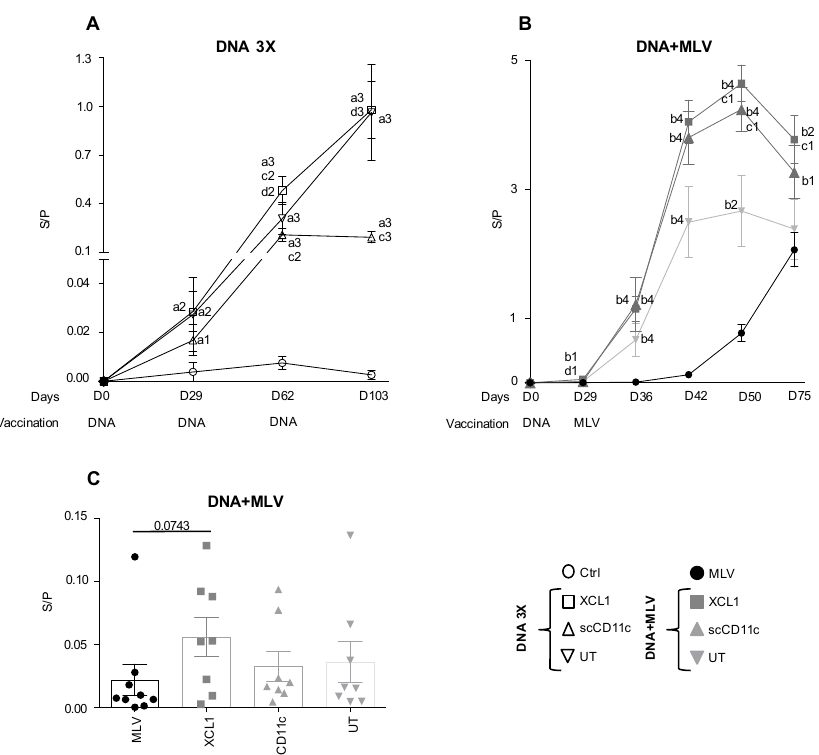
Figure 6. Anti-N IgG responses in serum and nasal secretions induced by DNA 3X and DNA + MLV regimens. ( A , B ) Sera from the DNA 3X groups and from the DNA + MLV groups were collected on the indicated days and analyzed at a 1:40 dilution for anti-N IgG detection with the Ingezim PRRS 2.0 kit. The S / P ratios are reported as means ± sem per group. The vaccine dates and types are shown. ( C ) Nasal secretions were collected on D0 and D75 in the DNA + MLV groups. The secretions were analyzed at a 1:2 dilution for anti-N IgG detection with the Ingezim PRRS 2.0 kit. The S / P ratios for